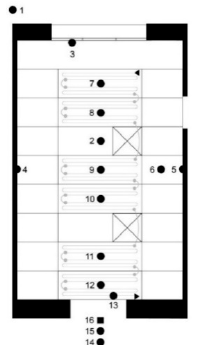
Figure 2. Position of the measuring points.